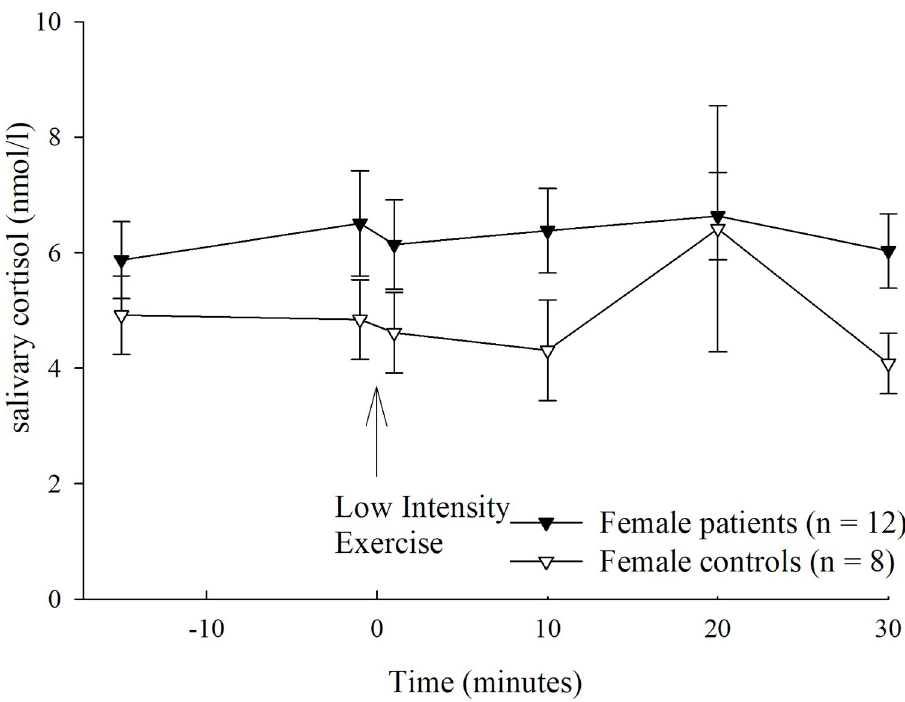
Fig 4. Cortisol response under Low Intensity Exercise (LIE) in female patients with panic disorder and healthy controls. Abbreviations / see S3 File: LIE, low intensity exercise.